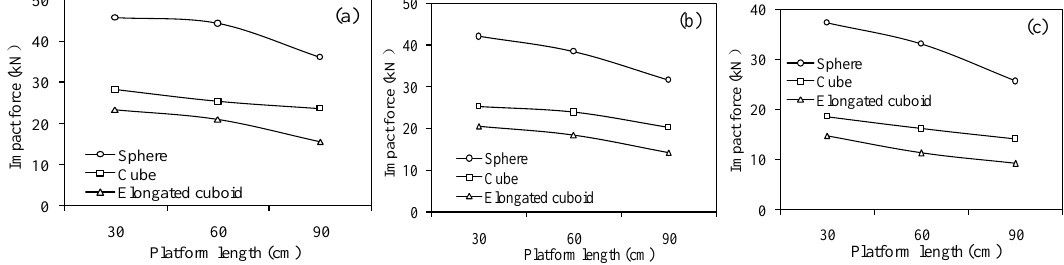
Figure 9. Influence of platform length on the impact force by different shapes of rockfalls: (a) 6kg, (b) 5kg, and (c) 4kg.